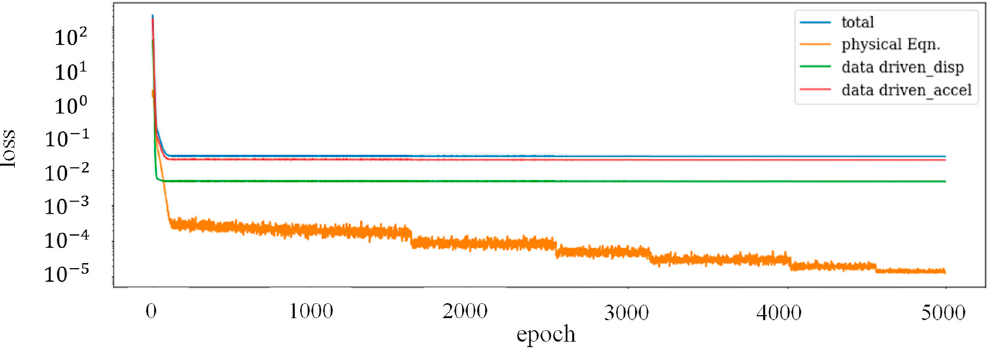
Figure 10. PINN loss function with three periods of training by displacement and acceleration input.